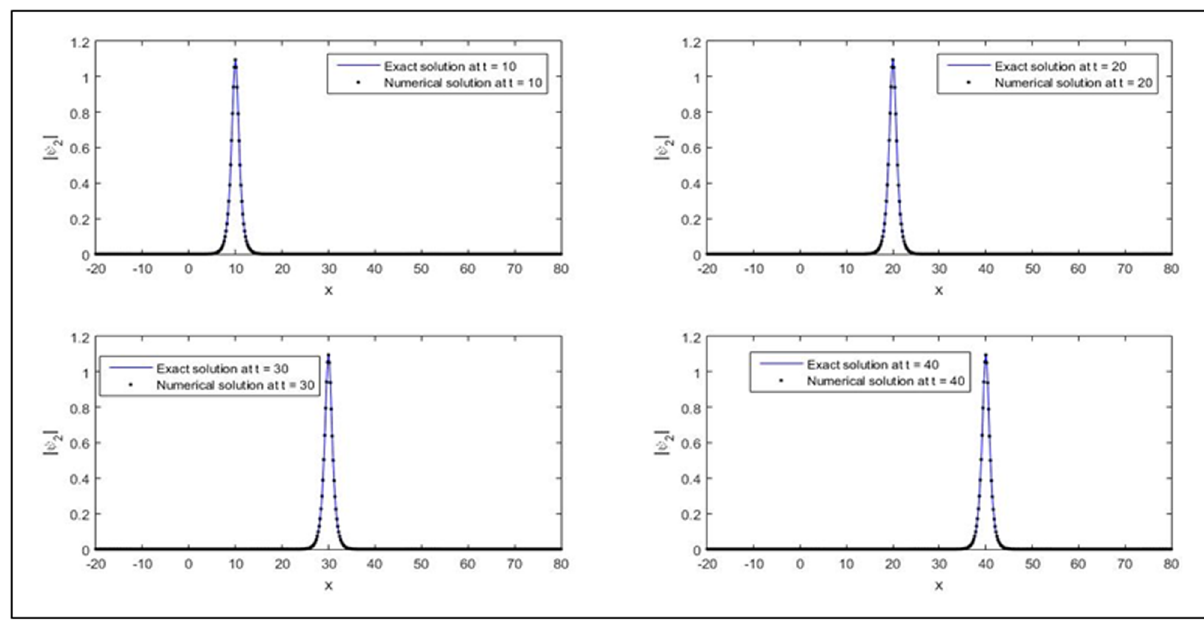
, and = τ 1 at = t 10 , 20, 3